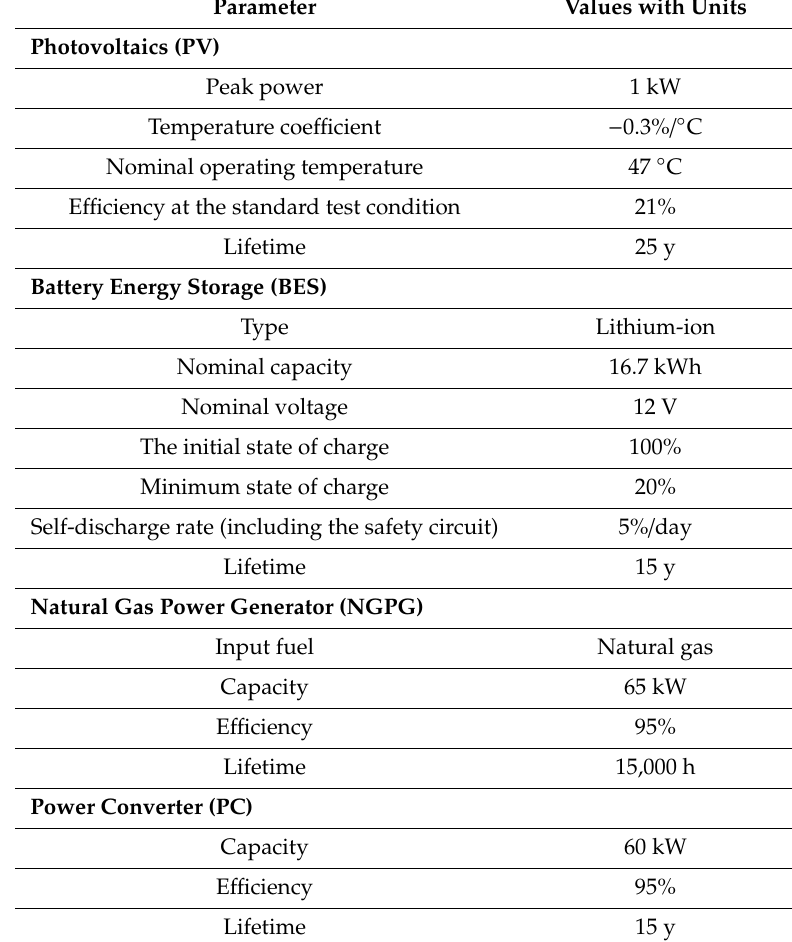
Table 3. Technical specifications of the power supply systems